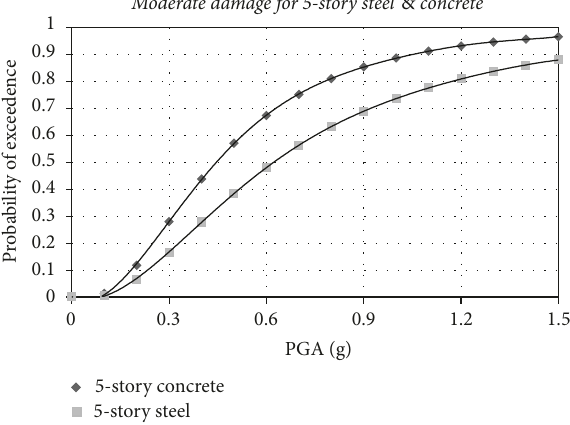
Figure 9: Comparison of the fragility of the 8-story steel and RC frame buildings for the extensive damage state.